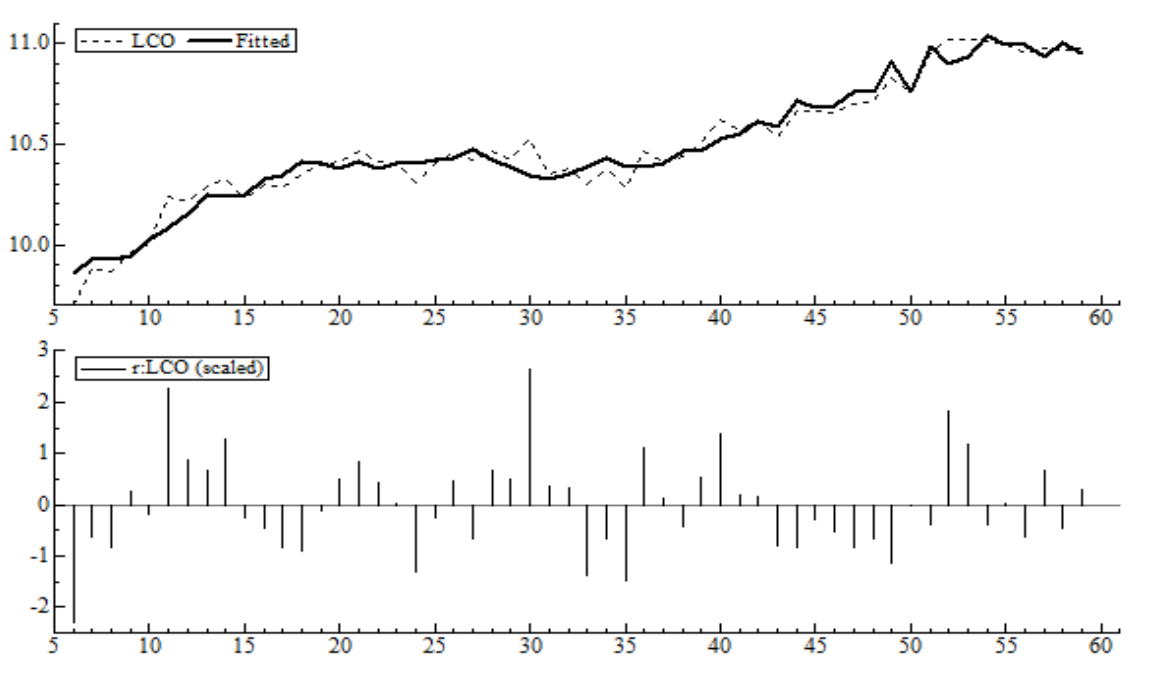
Figure 5. Results for the long-term model of CO 2 emissions (Norway): 3. See Equation (4). Fitted model top graph; residuals bottom graph.